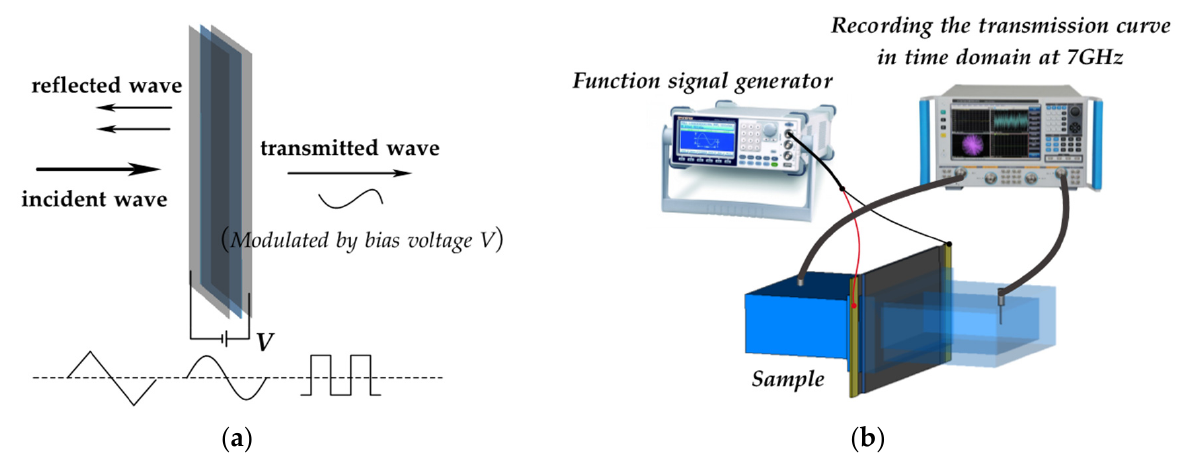
Figure 8. ( a ) The diagram and ( b ) the setup of the dynamic control on SE